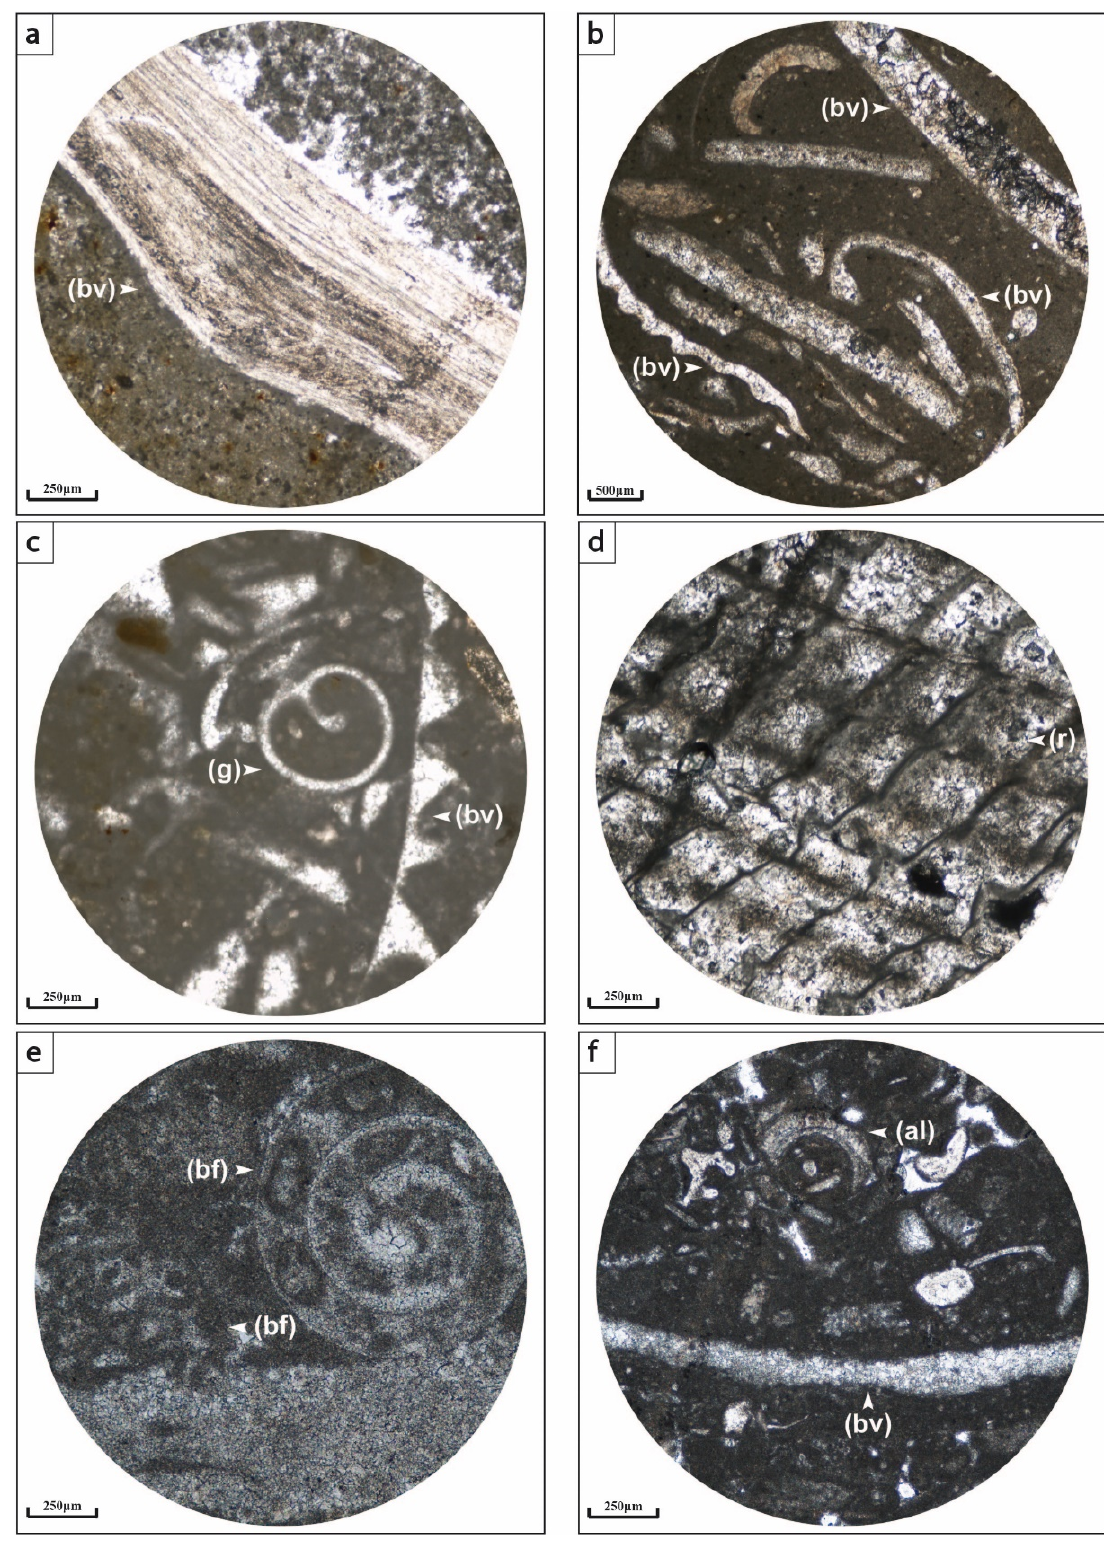
Figure 4. Thin section photographs of limestone microfacies of the Akrabou Formation in the Tazzouguerte section. ( a ) wackestone microfacies with bivalves (bv); ( b ) bioclastic wackestone to packstone with bivalves (bv); ( c ) bioclastic wackestone with gastropod (g) and bivalves; ( d ) details of a rudist shell (r); ( e ) bioclastic wackestone to packstone with benthic foraminifera (bf); ( f ) packstone microfacies with bivalves (bv) and algae (al).